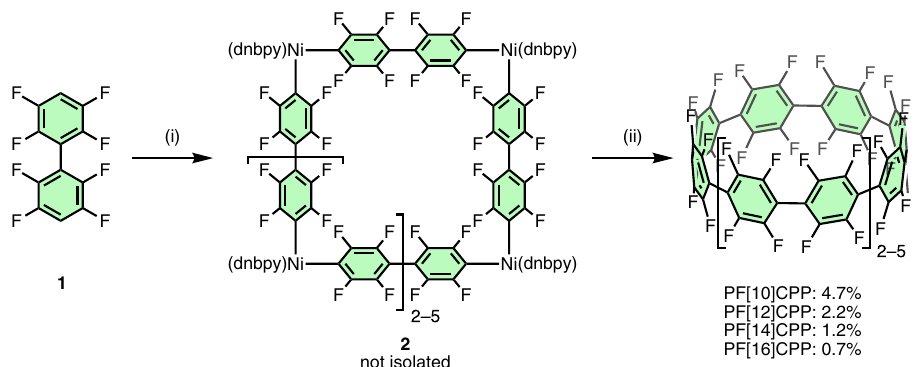
Fig. 2 Synthesis of PFCPPs. Reaction conditions: (i) LDA, Ni(dnbpy)Br 2 , THF, − 78 °C, 30 min; (ii) DDQ, m -xylene, 130 °C, 5 h. LDA = lithium diisopropylamide; dnbpy = 4,4 ′ -di- n -nonyl-2,2 ′ -bipyridyl; DDQ = 2,3-dichloro-5,6-dicyano- p -benzoquinone.